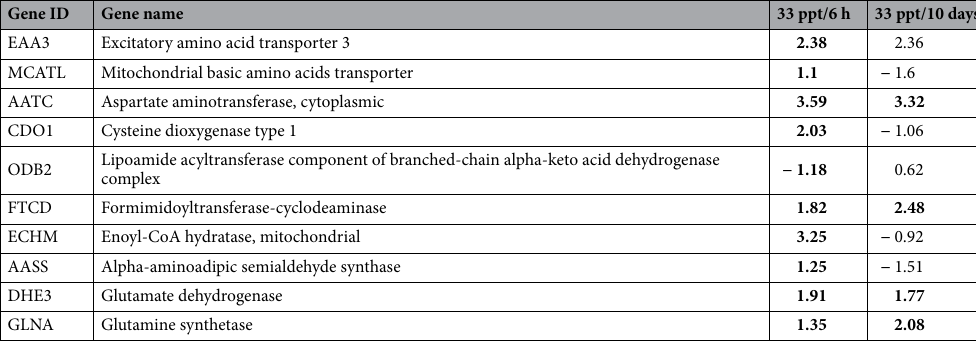
Table 2. Log2 fold change of differentially expressed transcripts of interest in 33 ppt groups. Significant differences (FDR < 0.001) are in